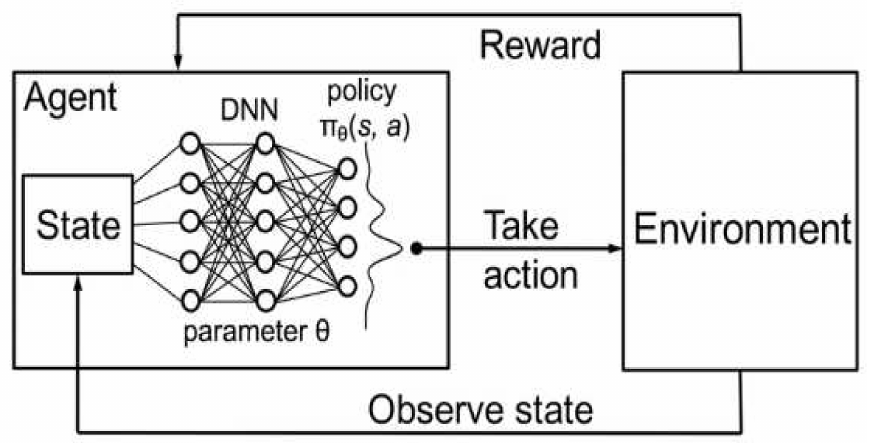
Figure 1. Deep reinforcement learning